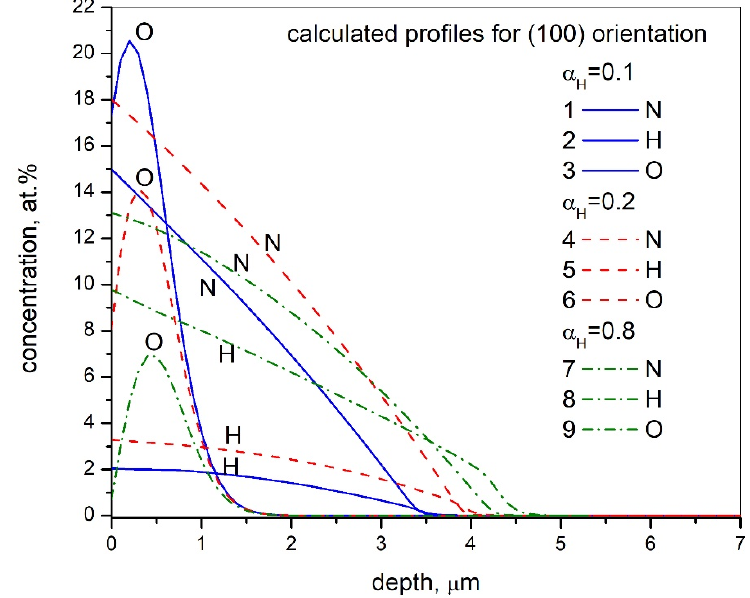
Figure 5. Depth profiles of nitrogen N, hydrogen H and oxygen O calculated at different values of parameter α H (hydrogen adsorption sticking coefficient).